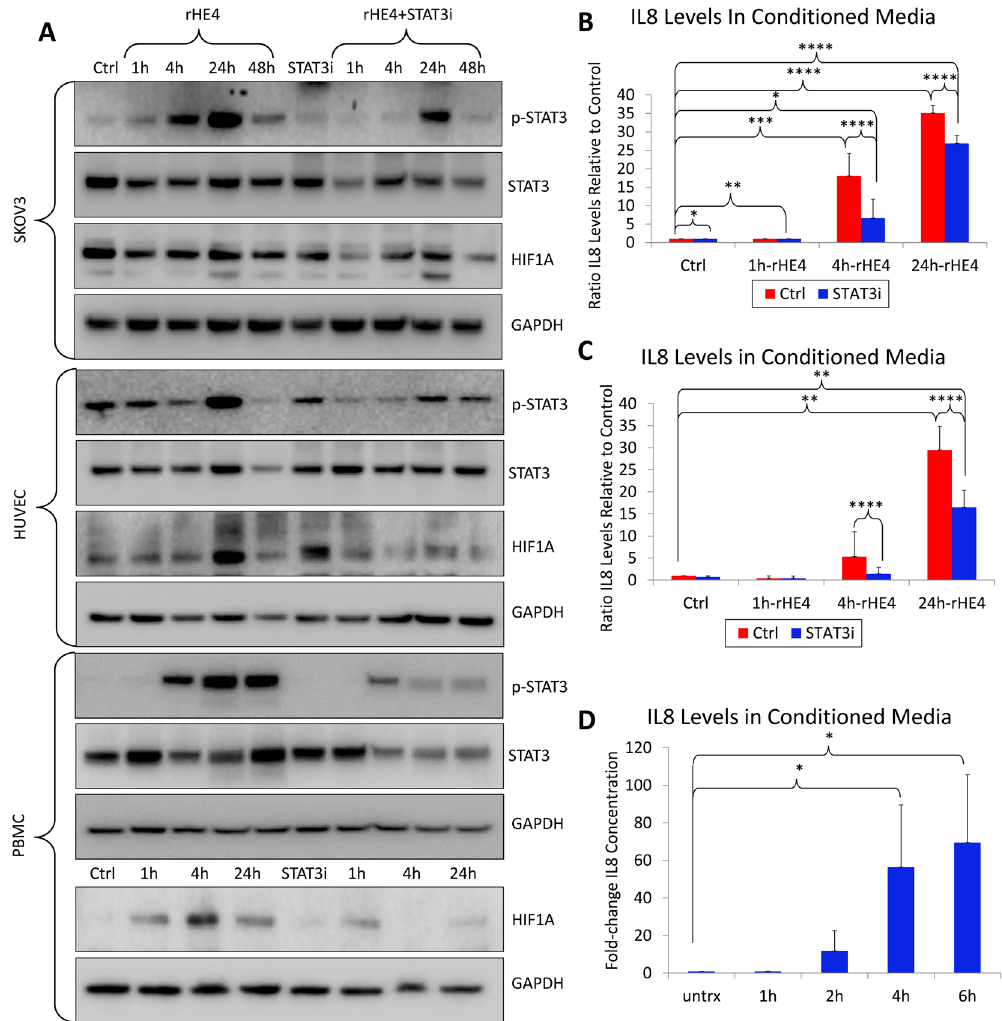
Figure 3. HE4-mediated STAT3 activation and upregulation of IL8 and HIF1A is blocked by STAT3 inhibition ( A ) Upregulation of phospho-STAT3 in SKOV3 cells, HUVECs, and PBMCs by rHE4 treatment. Upregulation of HIF1 α by rHE4 observed in HUVECs and PBMC. STAT3 activation and HIF1A levels were ablated by treatment with a STAT3 inhibitor. Boxes separate images from the same gel for each cell type. Blots were either subsequently reprobed for various antibodies, or stripped and reprobed in the case of STAT3/p-STAT3. (B) ELISA revealed increased secretion of IL8 by PBMC treated with 20 nM rHE4 from 4–24 h post-treatment, which was suppressed by STAT3 inhibition. (C) ELISA revealed increased secretion of IL8 by PBMC treated with 1 nM rHE4 from 4–24 h post-treatment, which was suppressed by STAT3 inhibition. (D) ELISA revealed IL8 secretion by PBMC was increased as early as 2 h post-treatment with rHE4. Error bars represent standard deviation of ≥ 3 biological replicates. * p < 0.05, ** p < 0.005, *** p < 0.005, **** p <